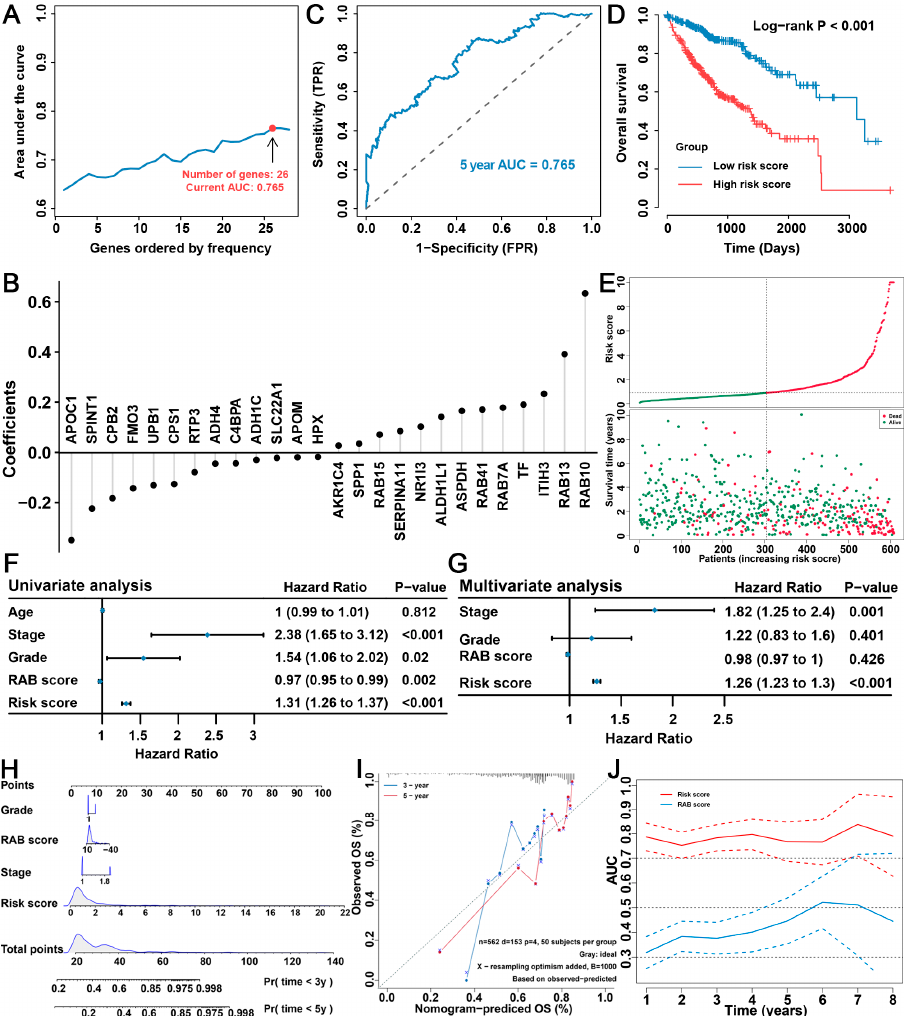
Figure 6. Construction of the RAB risk score for prognostic evaluation. ( A , B ) Iteration LASSO Cox regression analysis constructed a RAB risk score with 26 genes. ( C ) The AUC value was 0.765, and ( D ) the survival curve for a RAB risk score of the pooled HCC cohort is shown. ( E ) The survival time of each HCC patient with a different RAB risk score. ( F ) Univariate analysis and ( G ) multivariate analysis containing the RAB score, the RAB risk score, and clinical factors. ( H ) The comprehensive nomogram for predicting the probabilities of HCC patients with 3- and 5-year OS in the pooled HCC cohort. ( I ) The calibration plots for predicting HCC patients with 3- and 5-year OS in the pooled HCC cohort. The nomogram-predicted probability of survival is plotted on the x -axis; actual survival is plotted on the y -axis. ( J ) The time-dependent AUC values of the RAB score and the RAB risk score for the prediction of 3- and 5-year survival rates in the pooled HCC